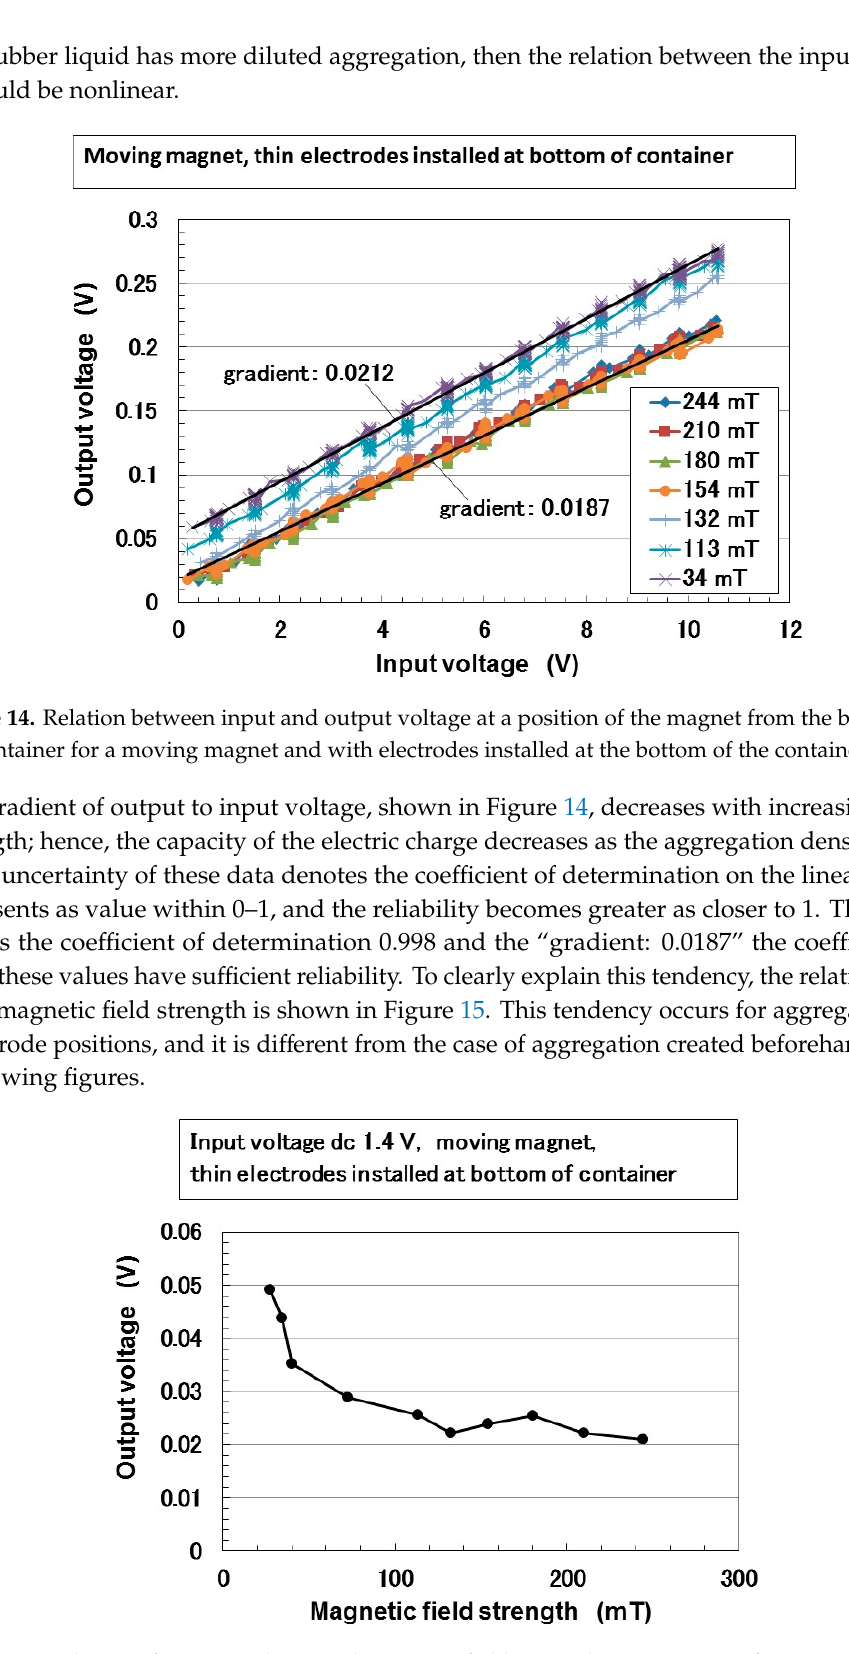
Figure 15. Relation of output voltage and magnetic field strength at a position of magnet from the bottom of container for a moving magnet with electrodes installed at the bottom of the container and application of an input voltage of dc 1.4 V.